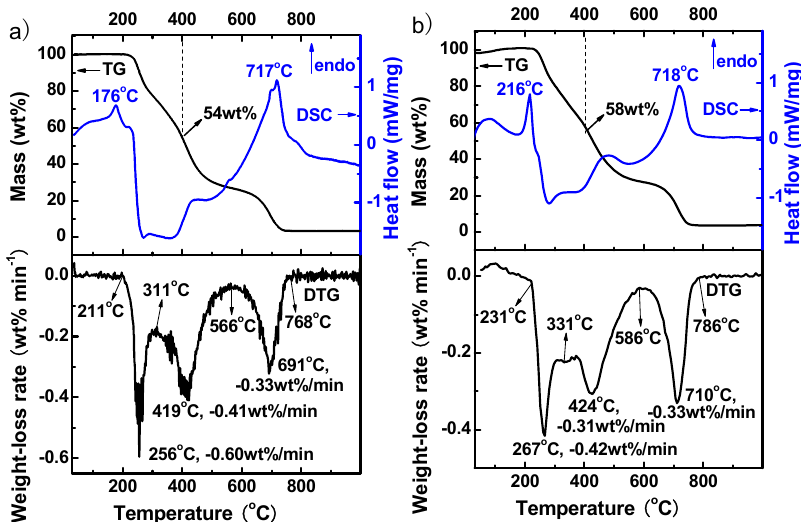
Figure 8. Thermogravimetry (TG), differential thermogravimetry (DTG), and differential scanning calorimetry (DSC) curves in nitrogen for PBT powder prepared with ( a ) I 2 and ( b ) H 2 O 2 .